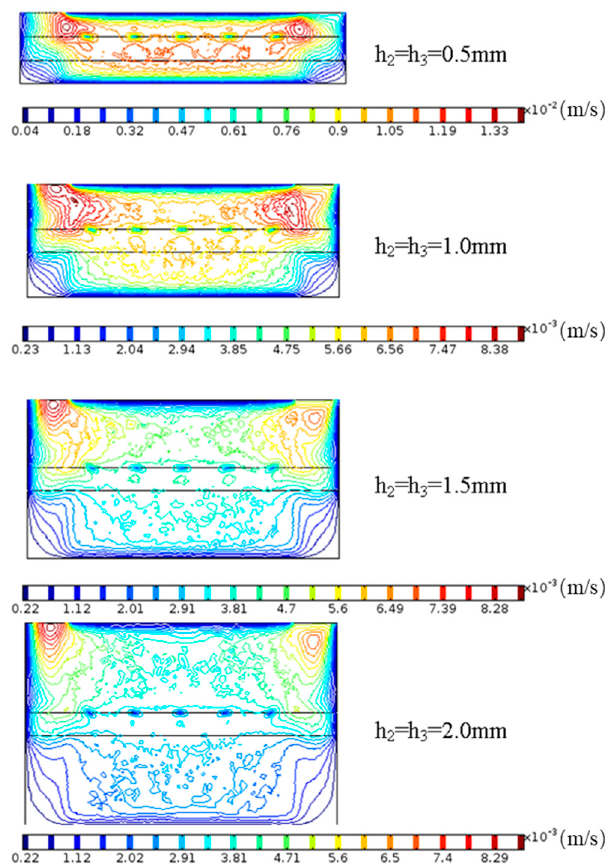
Figure 4. COMSOL simulation results of microchannel height (flow rate f r = 1 mL/min).